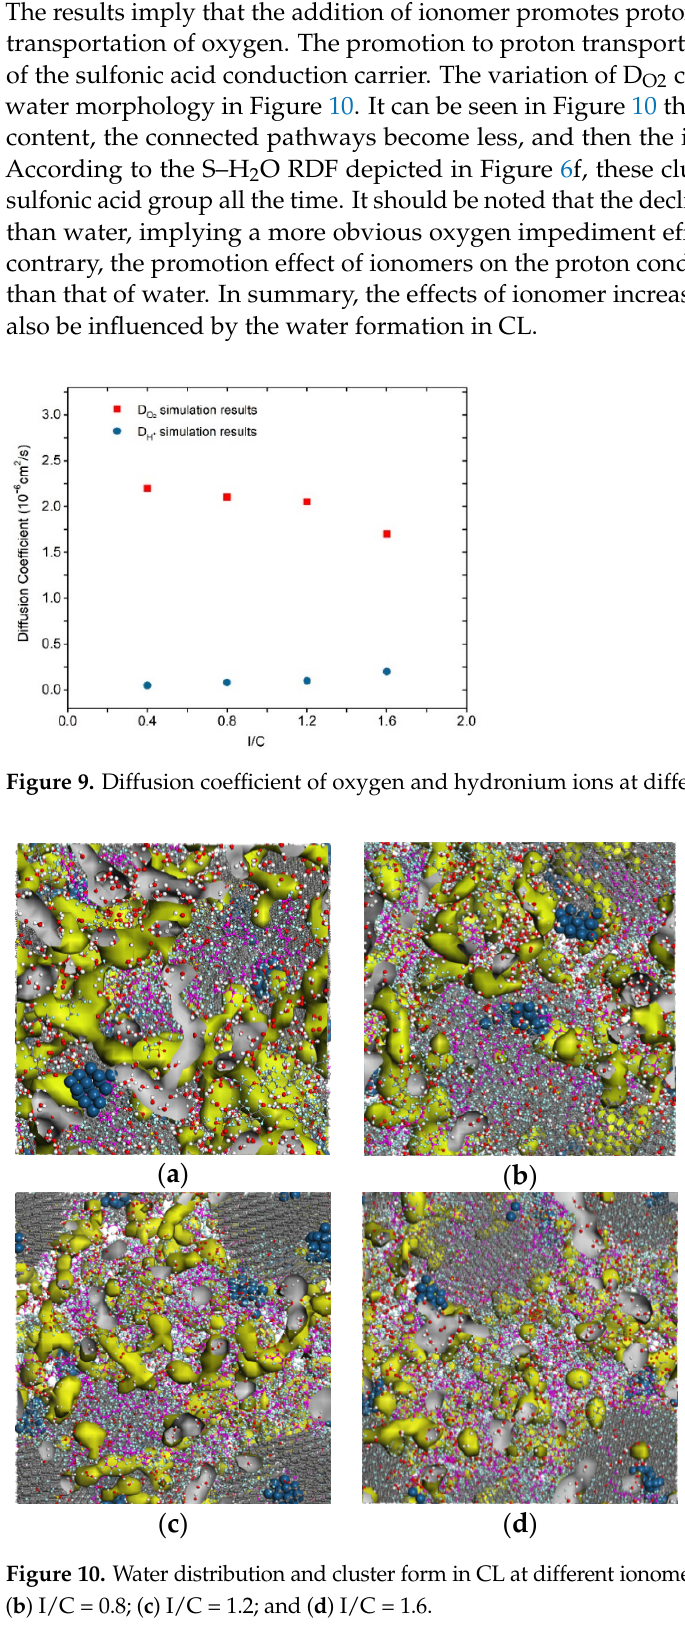
( d ) Figure 8. Water distribution and cluster form in catalyst layer (CL) at different water contents: ( a ) water clusters distribution at λ = 1; ( b ) water clusters distribution at λ = 4; ( c ) water clusters distri- bution at λ = 7; and ( d ) water clusters distribution at λ = 10. The variation of the D O2 can be explained in terms of the three diffusion ways of ox- ygen in the CL system—diffusing in water, diffusing in gas, and diffusing across the gas- water interface. In fact, the “gas” refers to the space that is not occupied by water and ionomer. When the λ is quite small, the diffusion of O 2 mainly occurs in the gas region so the diffusion coefficient is relatively large. As the water increase, the area of the gas–water interface increases, which further results in a higher oxygen diffusion resistance, as de- picted in Figure 8b,c. Therefore, the D O2 reduces when the λ = 4 and λ = 7. With a continu-